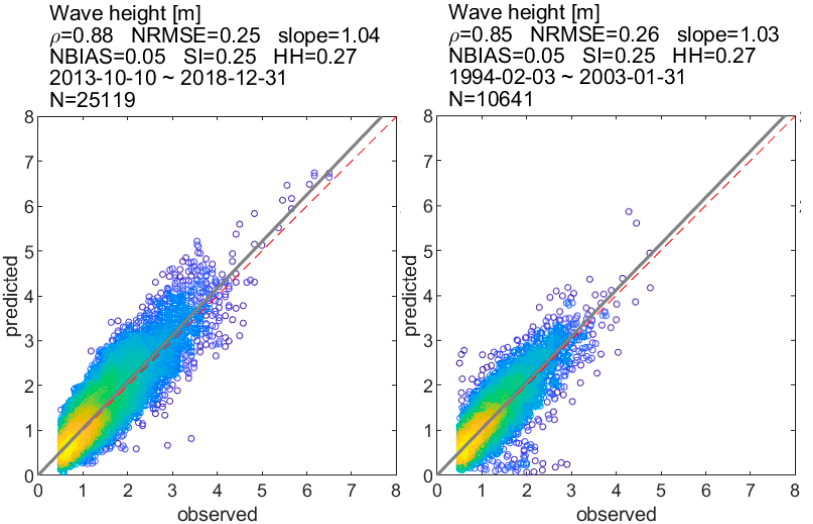
Figure 5. Comparison of significant wave height predicted and measured at Giannutri ( left ) and Torre Valdaliga ( right ) buoys.